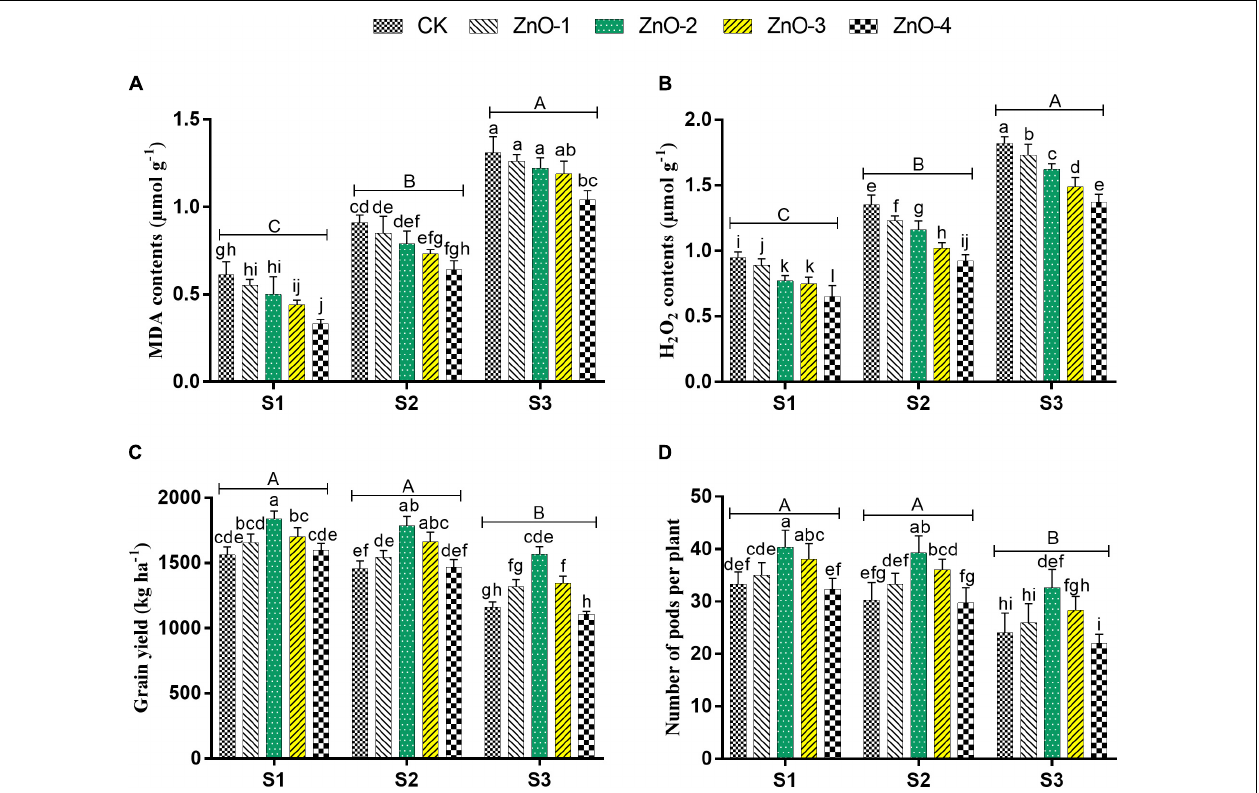
FIGURE 5 | Effect of foliar application of nano-ZnO on malondialdehyde (MDA) contents (A) , hydrogen peroxide (H 2 O 2 ) contents (B) , grain yield (C) , number of pods per plant, and (D) in Vigna radiata L. under sowing time generated heat stress. Nano-ZnO doses: CK (distilled water), ZnO-1 (15 mg l − 1 ), ZnO-2 (30 mg l − 1 ), ZnO-3 (45 mg l − 1 ), and ZnO-4 (60 mg l − 1 ). S1, First sowing-March 1 (recommended); S2, Second sowing-March 22 (late sown); S3, Third sowing-April 11 (late sown). Data are mean ( ± SE) of three replicates and different letters designate significant changes at Tukey’s test ( p < 0.05). In contrast, capital letters represent a significant difference among sowing time treatments and small letters represent a significant difference among the nano-ZnO